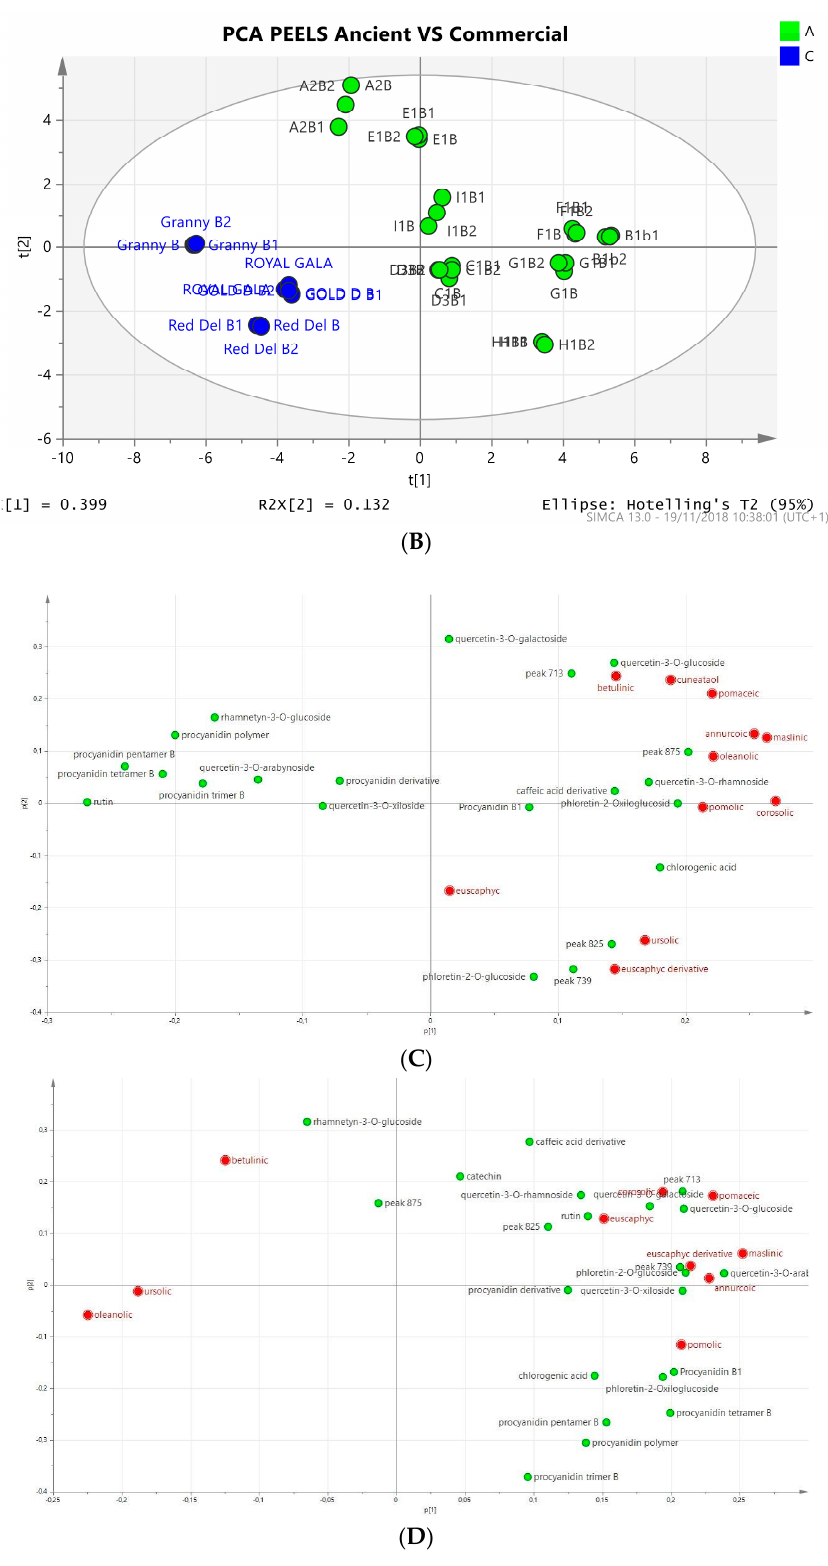
Figure 4. Score scatter and loading plots of the PCA obtained from the LC-MS datasets for pulps ( A , C ) and peels ( B , D ) of the analyzed apple samples. Commercial (blue) and Ancient (green) samples are highlighted. An evident clustering was observed. Triterpene acids and phenolic compounds are highlighted in the plot with red and green color respectively.